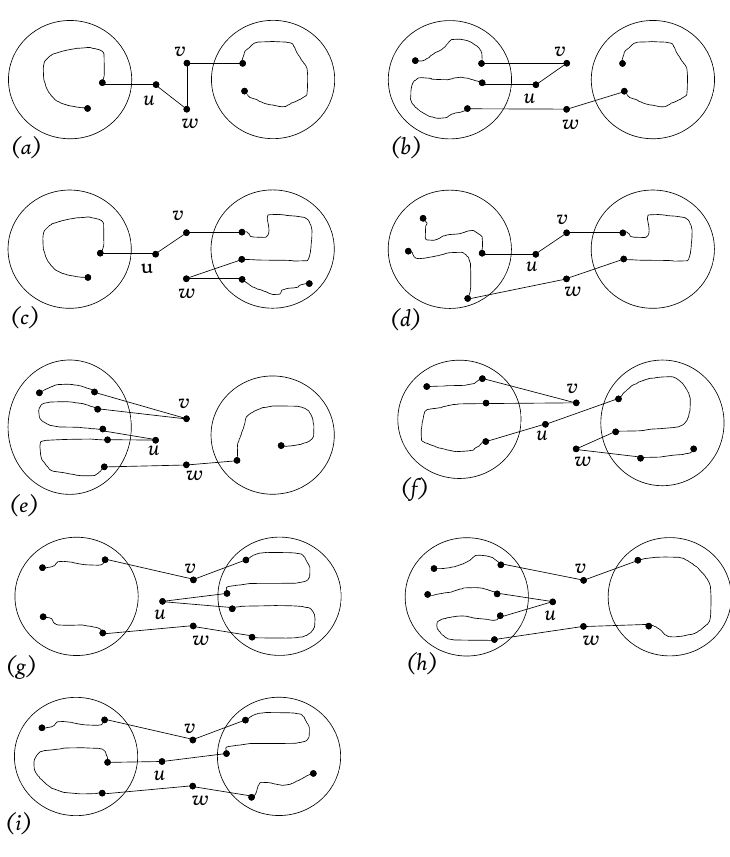
Fig. 11: The possible Hamilton paths through G